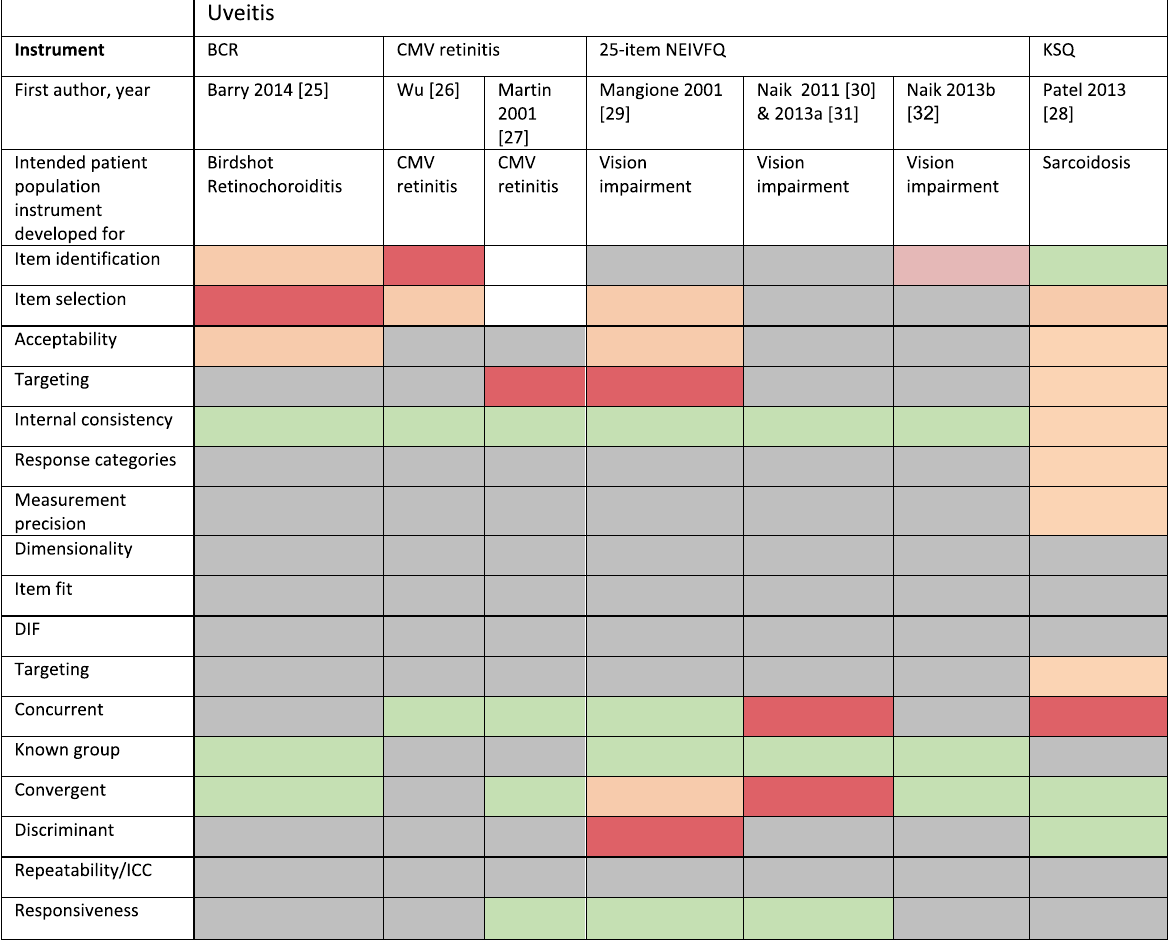
Green A, Orange B, Red C Grey: Not reported or not